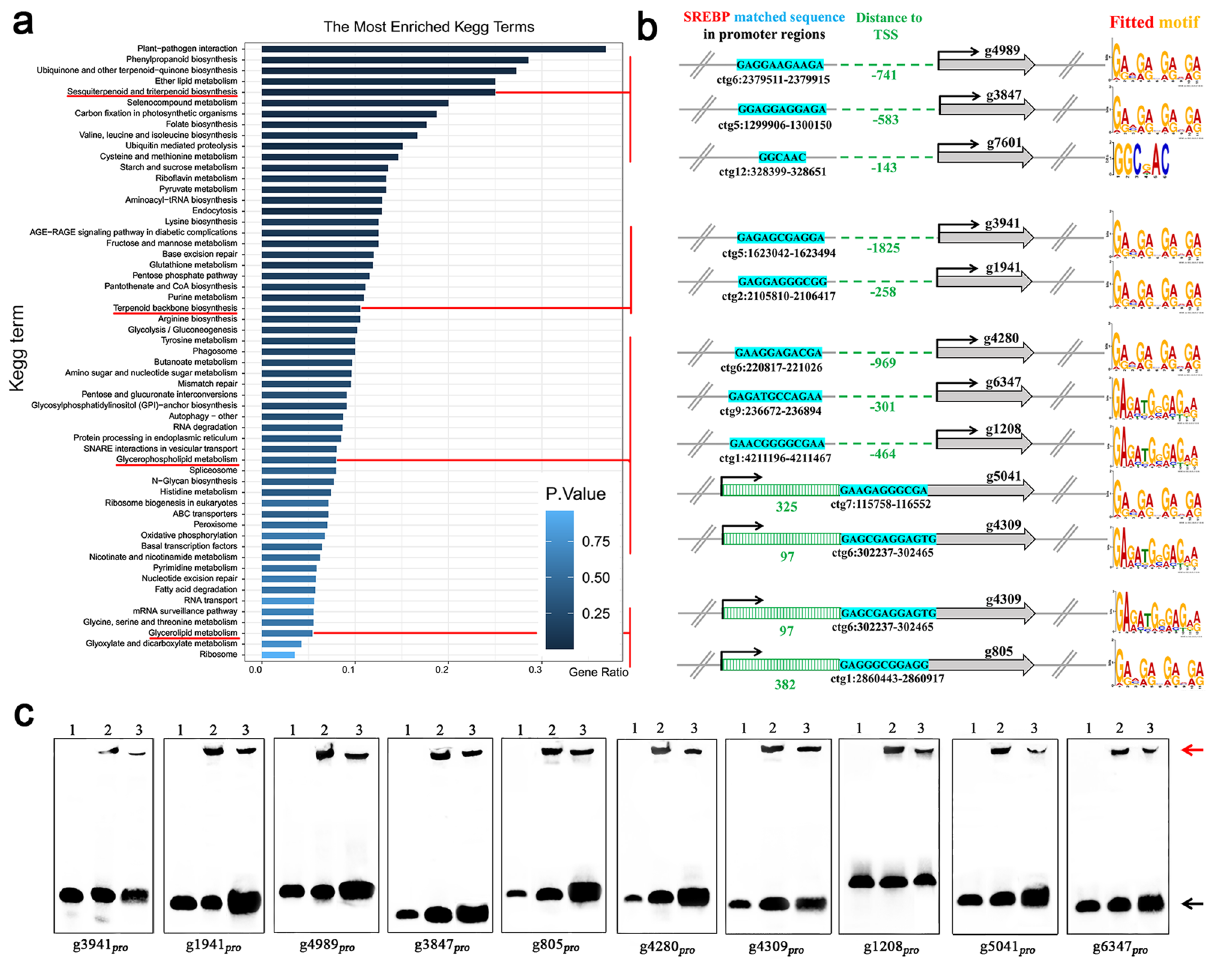
Fig. 3 Screening of SREBP target genes for terpenoid and lipid metabolism. a KEGG analysis of SREBP target genes. Clusters for terpenoid and lipid metabolism were highlighted by the red line. b Schematic diagram showing the genomic locations of SREBP target genes that involved in terpenoid and lipid metabolism, and corresponding matched DNA sequence, promoter regions, and fi tted motif. The conserved SREBP binding sequence was highlighted in blue shadow. c SREBP can bind to the DNA sequences in the targets promoter by EMSA. Line 1: the labelled DNA probe control. The labelled DNA probe was preincubated with 0.6 μ g SREBP-bHLH protein (Line 2), and an unlabelled competitor DNA probe (200× labelled DNA probe) was added (Line 3). Arrows indicate positions of protein-bound (red) and free (black) DNA